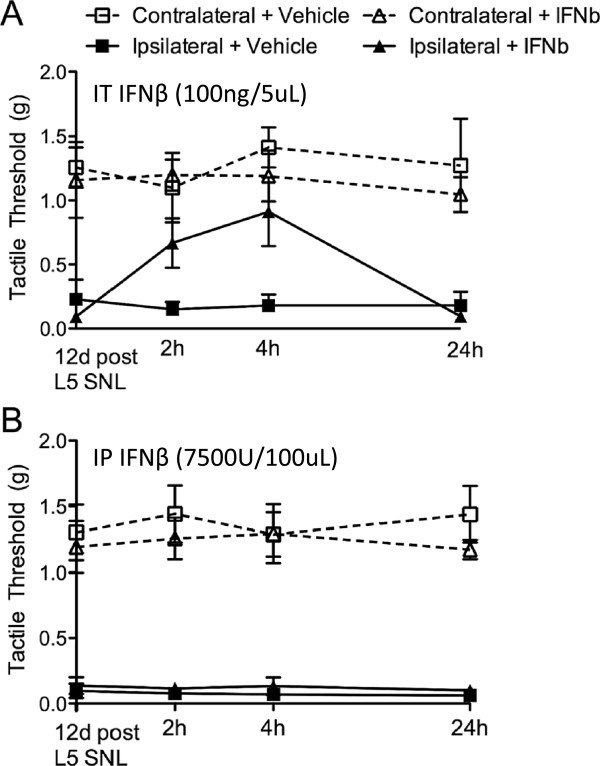
IT IFNβ transiently reverses L5 SNL induced tactile allodynia. Twelve days following L5 SNL, C57BL/6 mice received IFNβ either (A) intrathecally or (B) intraperitoneally. (A) IT IFNβ (100 ng/5 μL) transiently reversed the tactile allodynia present at 12 days post-L5 SNL in C57BL/6 mice. (B) IFNβ i.p. (7,500 U/100 μL) did not affect the tactile allodynia present at 12 days post-L5 SNL in C57BL/6 mice. Data expressed as mean ± SEM (n = 3–4 mice/group) and analyzed via 2-way ANOVA. Following IFNβ treatment there was a significant effect of the IT treatment (A) (P <0.05), but not the i.p. treatment (B).